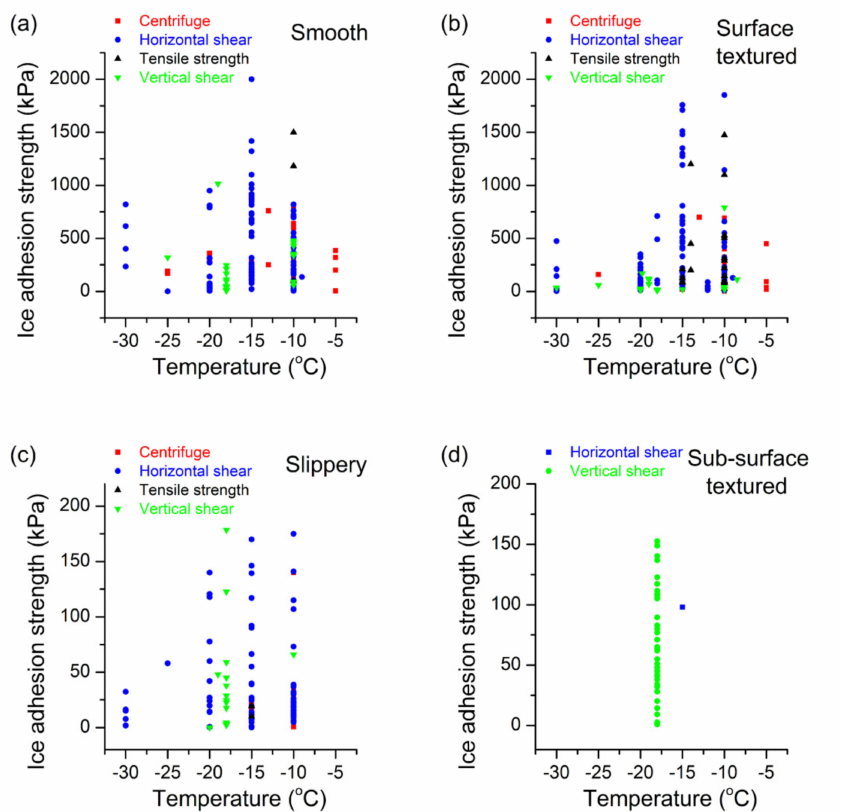
Figure 3. Ice adhesion strength plotted against temperature (i.e., range from 0 to − 30 ◦ C) by using different ice adhesion test methods (i.e., centrifuge, tensile, horizontal shear and vertical shear): ( a ) smooth surfaces, ( b ) textured surfaces, ( c ) slippery surfaces and ( d ) sub-surface textured surfaces. Data are collected from the literature